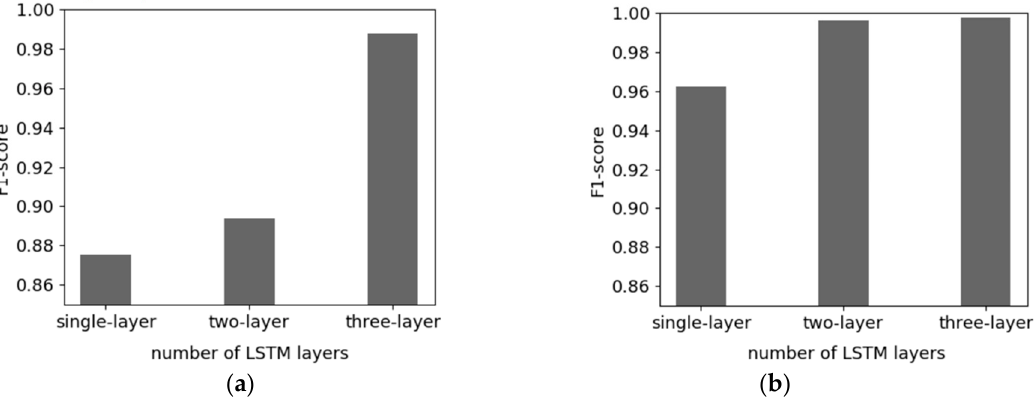
Figure 7. Performance comparison of the single or multi-layer (two or three-layer) LSTM models. The figure on the left shows the F1-score comparison based on the number of LSTM layers using the dataset of 30 per packet flows and 36 payload sizes. The figure on the right shows it using the dataset of 100 per packet flows and 1024 payload sizes. ( a ) The smallest dataset, and ( b ) the largest dataset.